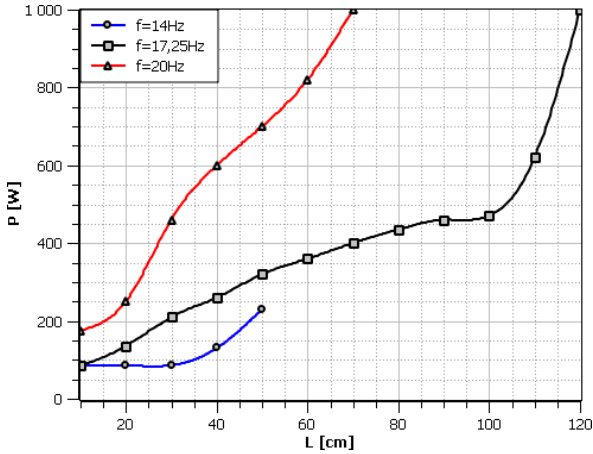
Figure 8: Minimum electrical power delivered to the extinguisher causing extinguishing effect in the function of the distance from the waveguide